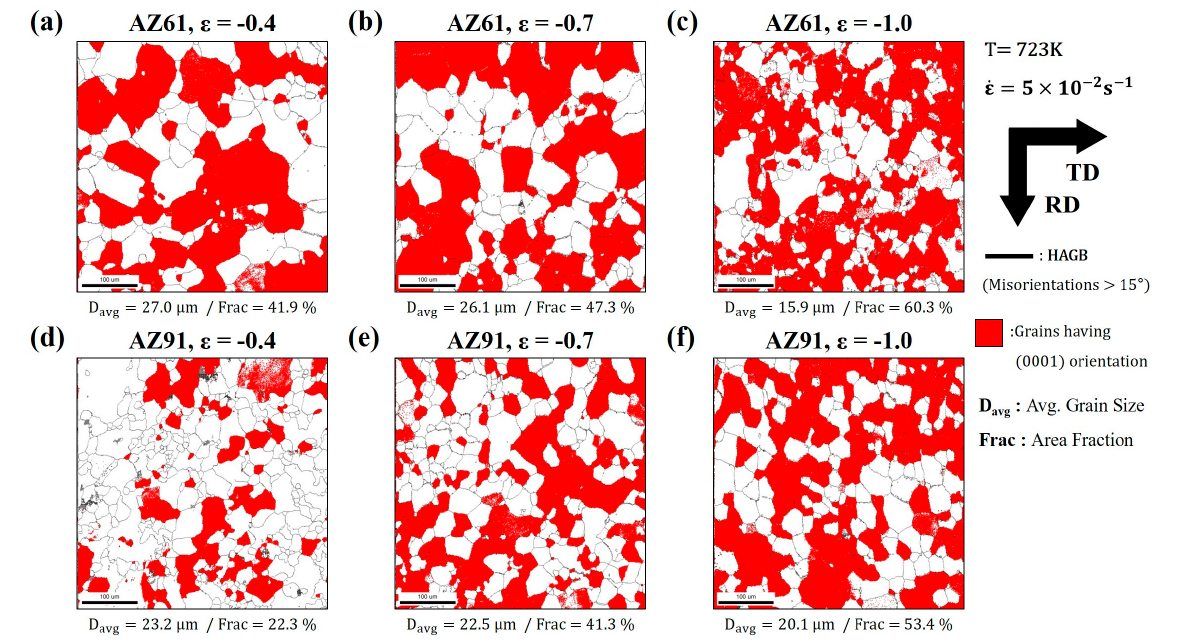
Figure 9. Grain structure observed at mid-plane sections after deformation at 723 K with a strain rate of 5.0 × 10 − 2 s − 1 up to true strains of ( a , d ) − 0.4, ( b , e ) − 0.7 and ( c , f ) − 1.0. (( a – c ): AZ61, ( d – f ): AZ91) Grains having a (0001) orientation are colored in red. The average grain size and the fraction of the (0001) grains are shown in each map. Table 2. Fraction of the boundaries with different misorientations based on the microstructure measured by EBSD of AZ61 and AZ91 alloys deformed at 723 K under a strain rate of 5.0 × 10 − 2 s − 1